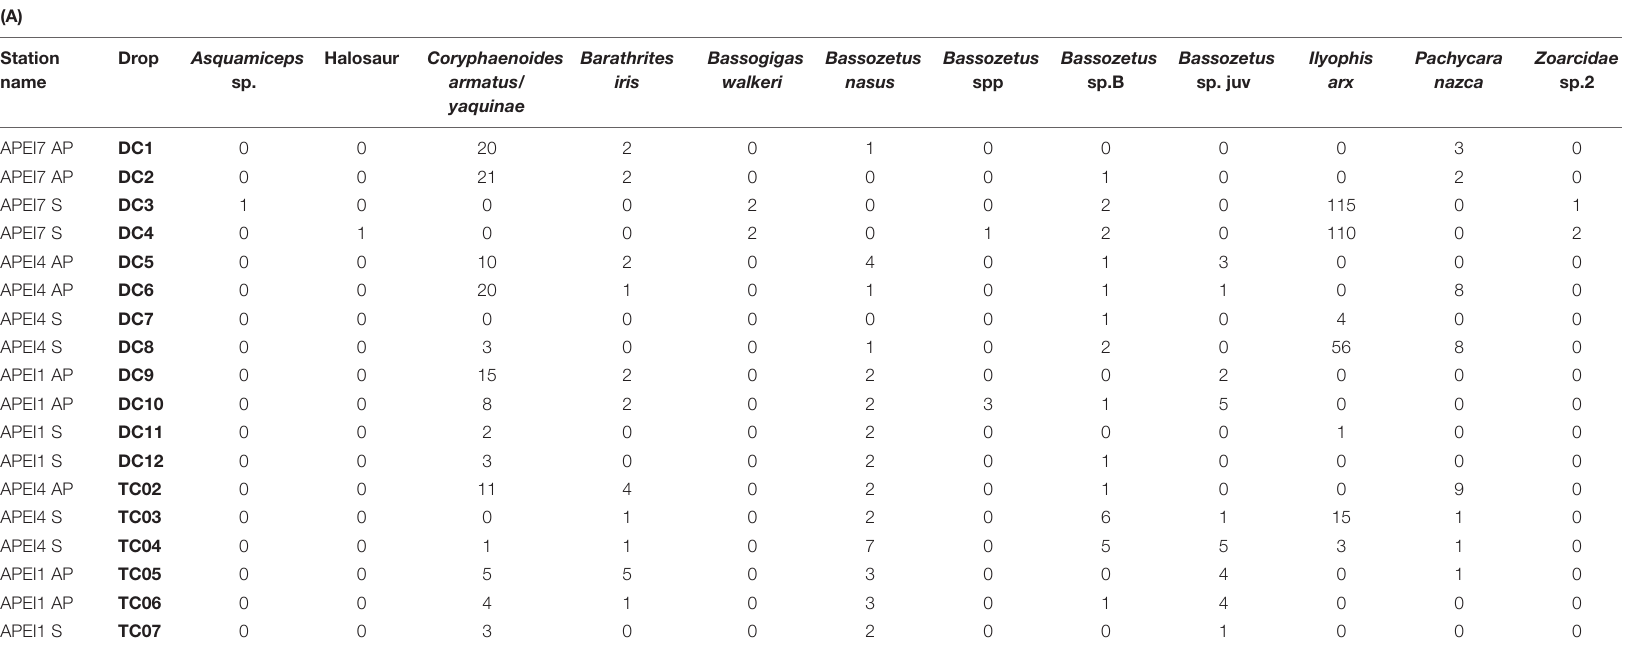
TABLE 3 | (A) Relative abundances (MaxN) of all bait-attending fishes in all successful deployments. (B) Relative abundances (MaxN) of all bait-attending invertebrate fauna in all successful deployments.